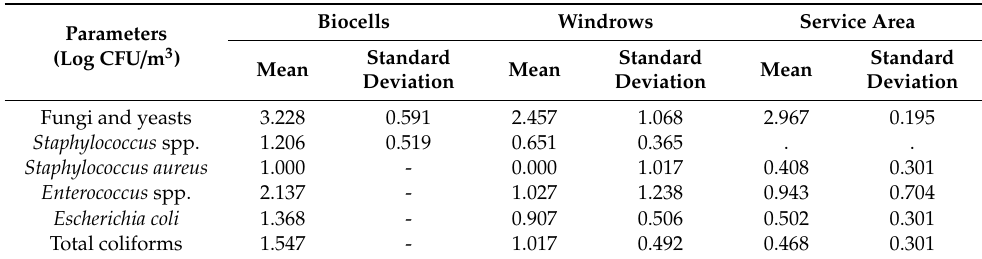
Table 5. Descriptive analysis of investigated parameters in relation to biocells, windrows, and service area application. CFU = colony forming